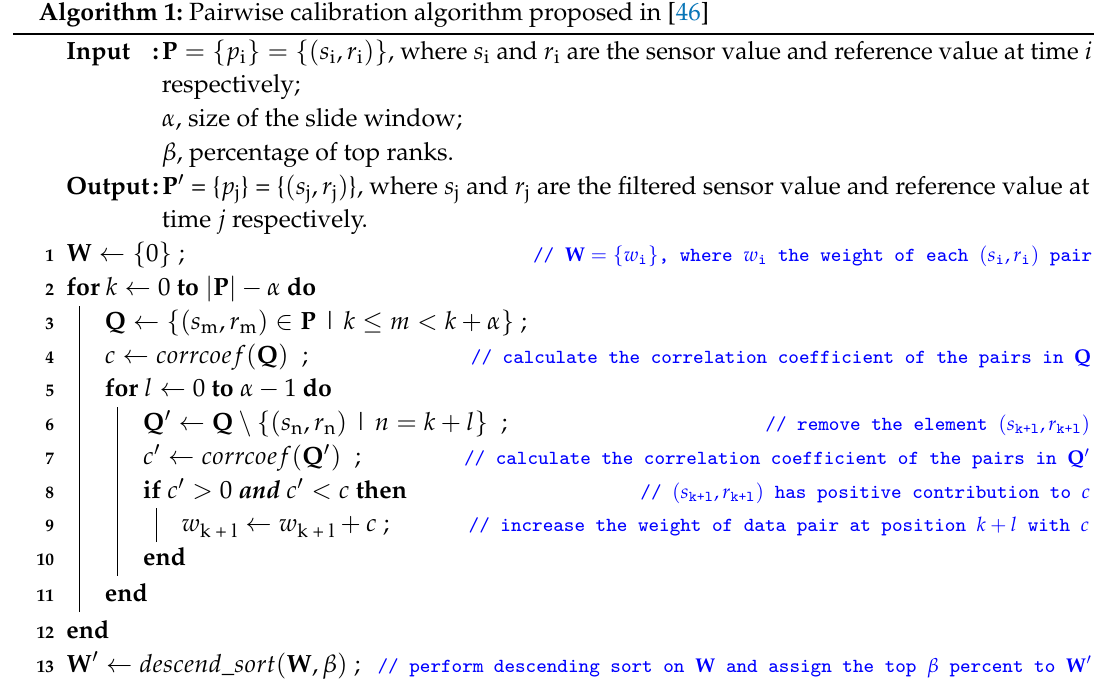
Figure 7. Collocation calibration sites. ( a ) HKO King’s park site; ( b ) EPD Tseung Kwan O site. Algorithm 1: Pairwise calibration algorithm proposed in